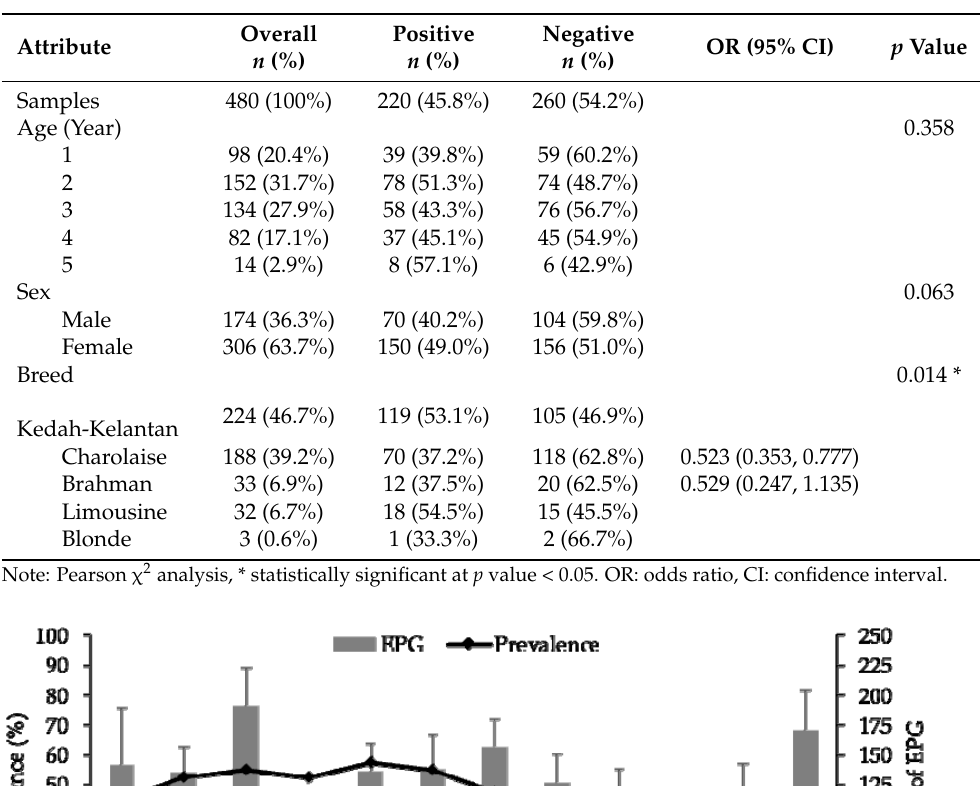
Table 1. Risk factors associated with cattle fascioliasis in Kelantan, Malaysia.